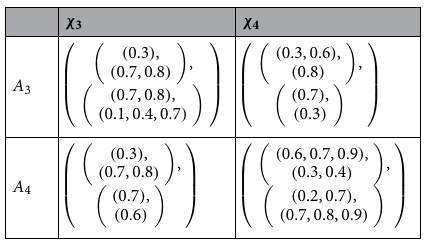
Table 5. Decision making information.